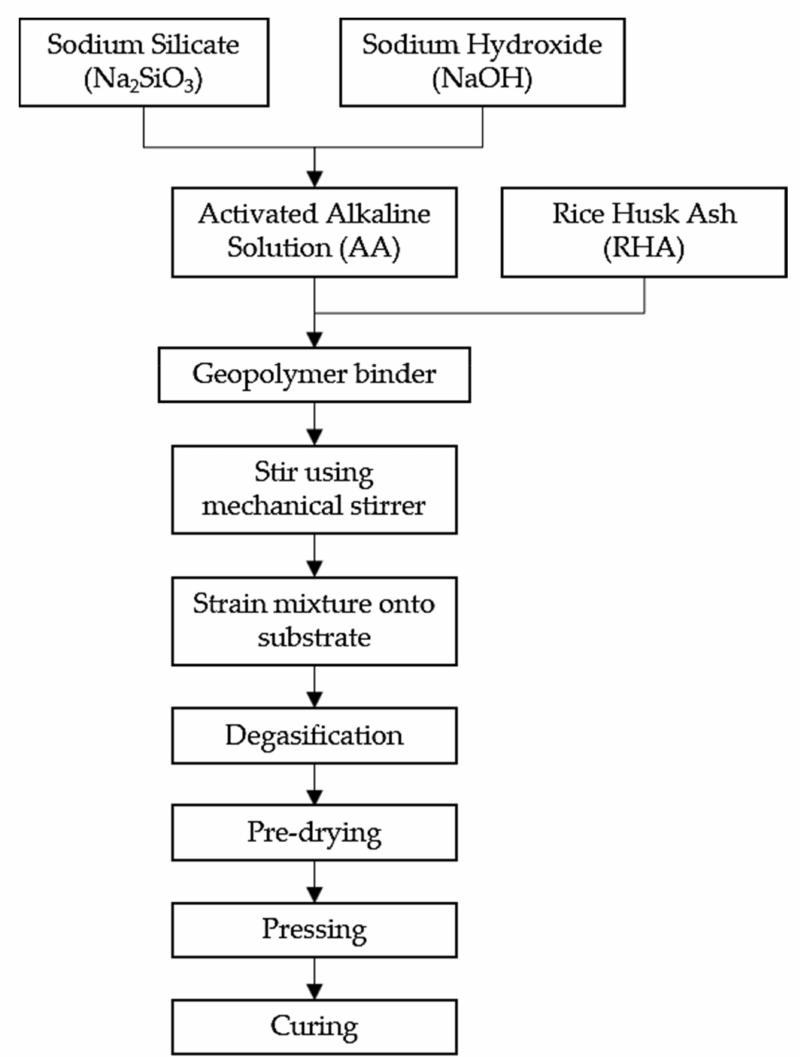
Figure 3. Flowchart for the fabrication of RHA-based geopolymer coating.